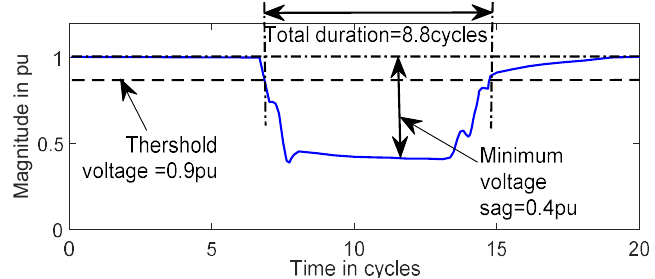
Figure 4. Illustration of voltage sag/dip for a threshold voltage of 0.9 pu.